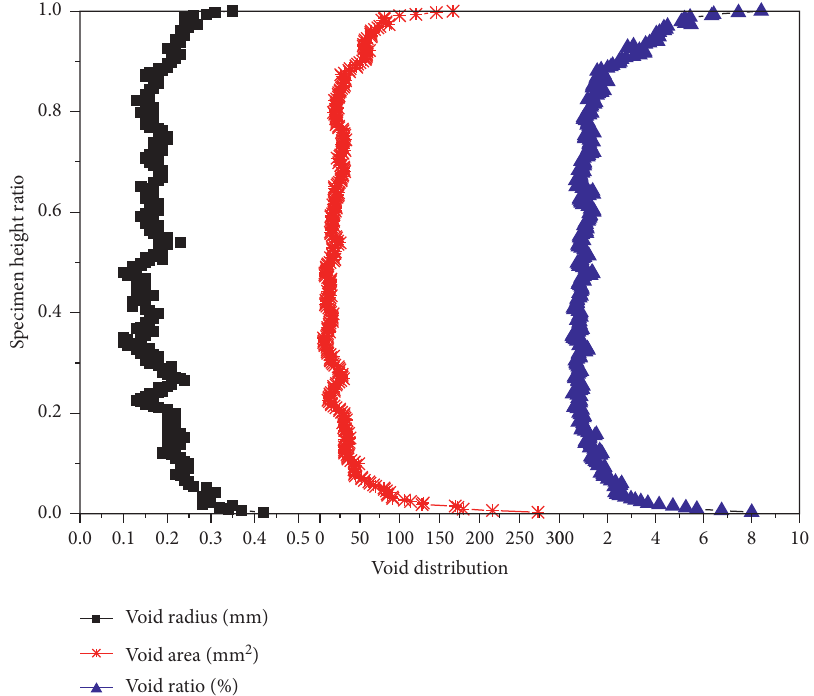
Figure 8: Air size distributions along with the SUP13 specimen height